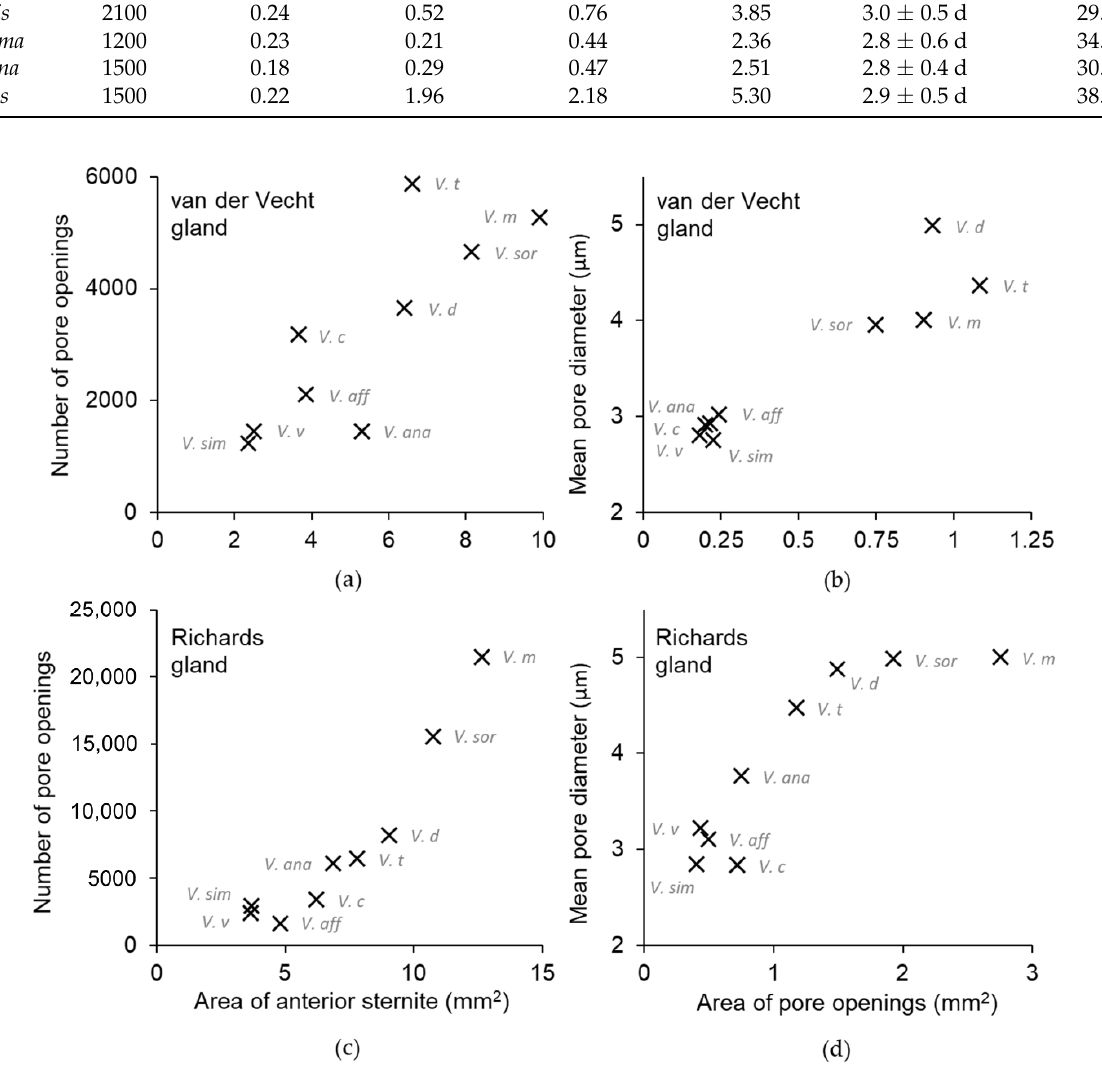
Figure 3. Significant correlations across species between features of the sternal glands. ( a ) Van der Vecht gland size (number of pore openings) increased as the size of the sixth metasomal sternite increased. ( b ) Mean pore diameter increased as van der Vecht gland size (area of pore openings) increased. ( c , d ) The same relationships are provided for the Richards gland on the fifth metasomal sternite. All estimates were pooled across images of specimens within species (species abbreviations are in gray).